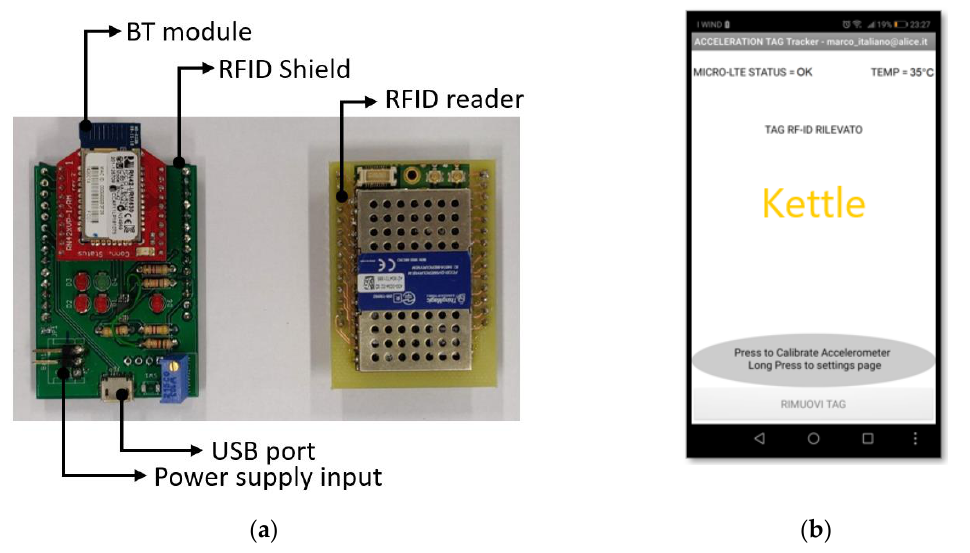
Figure 2. Device overview: ( a ) real view of the device; ( b ) the Android interface.